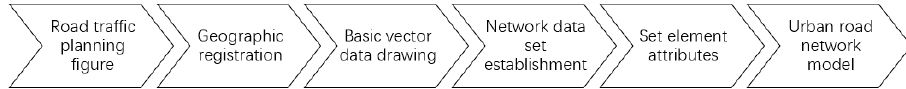
Figure 1. Planning road network model construction process.